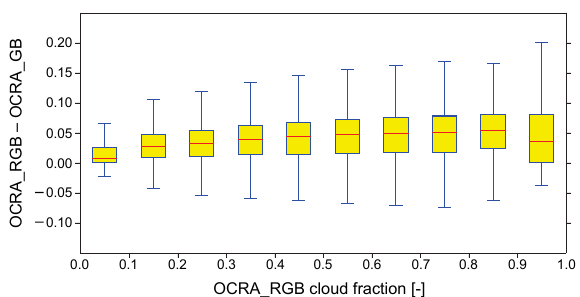
Figure 8. Box-and-whisker plot of the OCRA cloud fraction dif- ference using RGB and GB colours retrieved using GOME-2 data from 1 July 2012. The yellow boxes show the interquartile range, and median values are indicated as red lines. The overall median difference is